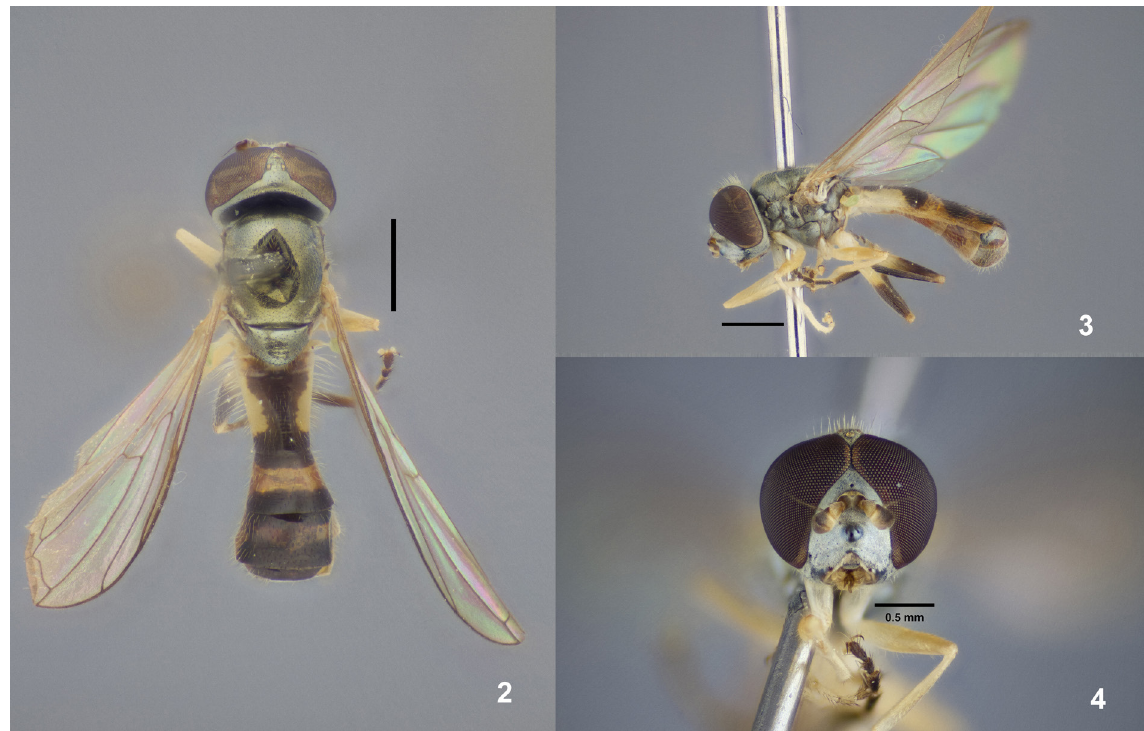
2 . Habitus, dorsal view. 3 . Habitus, left lateral view. 4 . Head, frontal view. Scale bars: 2–3 = 1 mm; 4 = 0.5